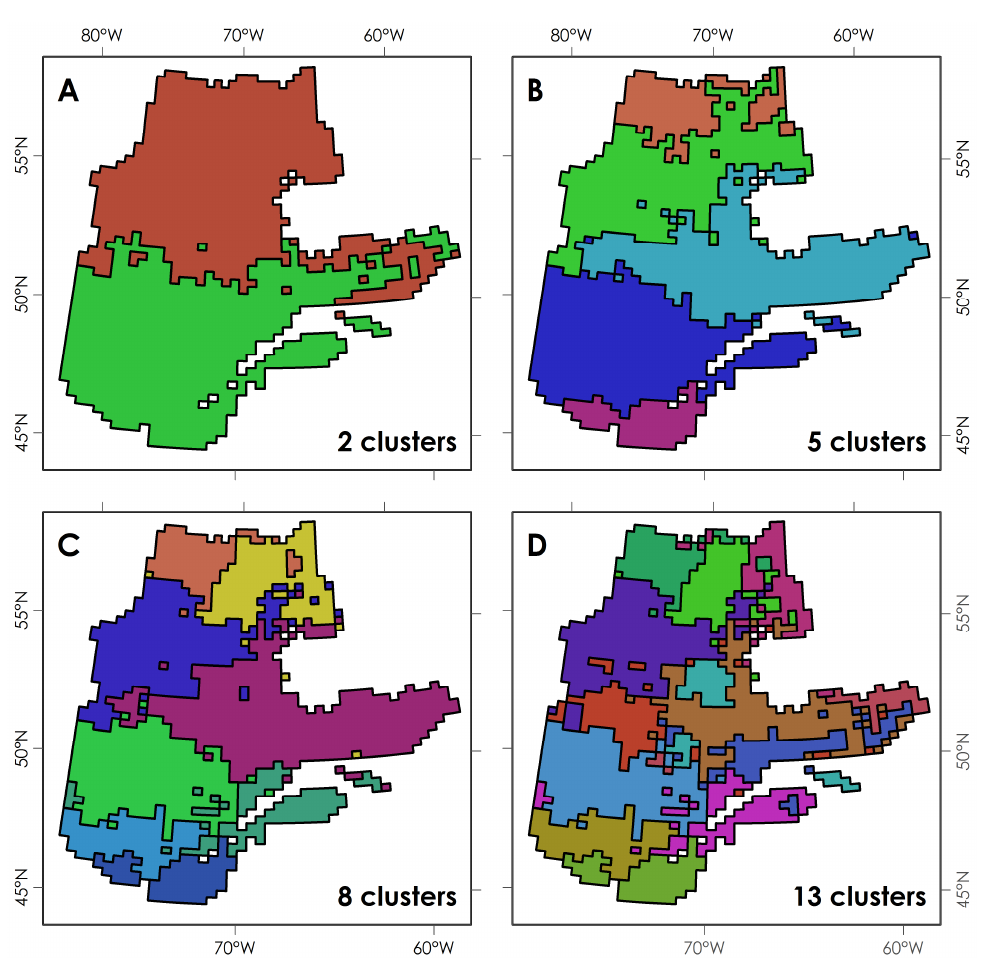
Figure 3. Unconstrained clustering using landscape pattern metrics showing partitioning of Quebec into 2 ( A ), 5 ( B ), 8 ( C ), and 13 ( D )